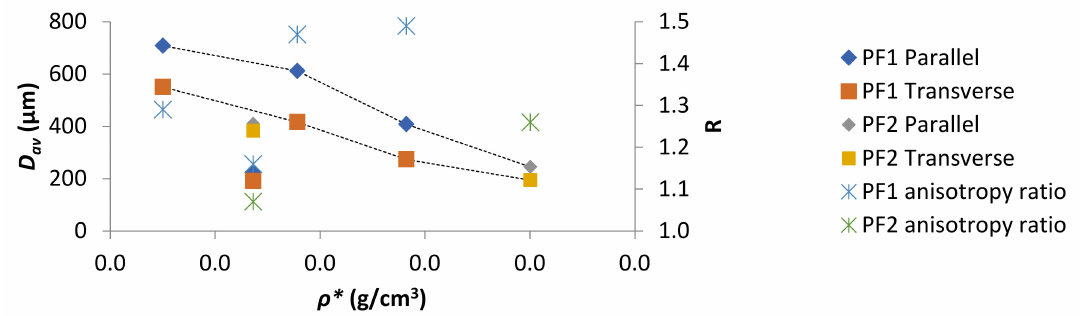
Figure 4. PF D av and R as a function of ρ * .